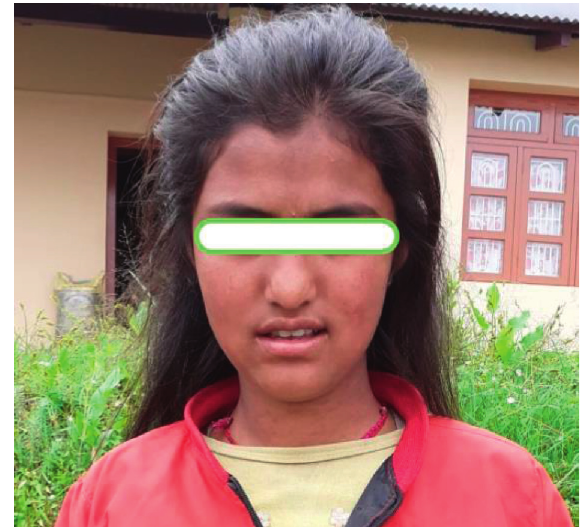
Figure 3: Patient on follow-up at 4